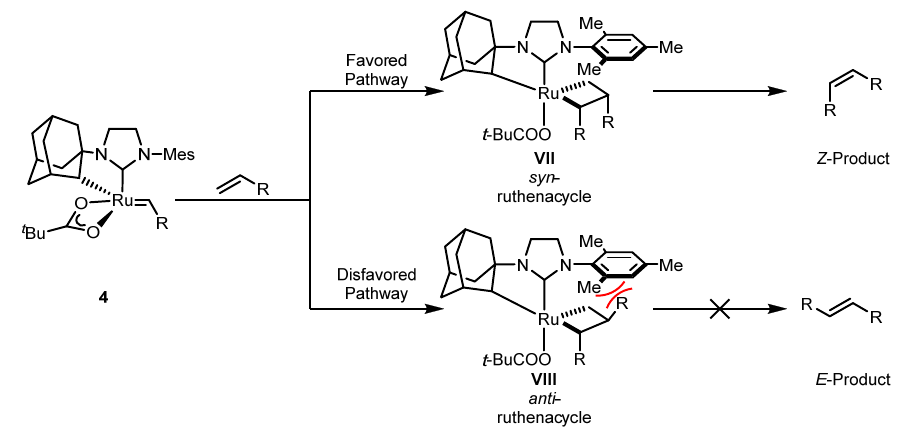
Figure 3. Depiction of the steric interactions leading to the favored Z -selective metathesis pathway using 4 .